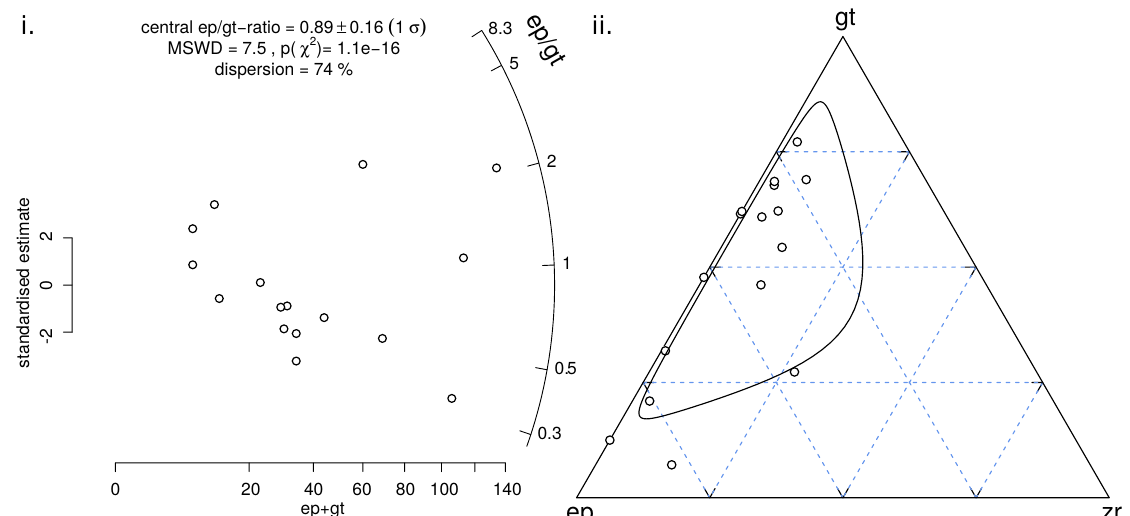
Figure 2. ( i ) Radial plot of the epidote/garnet-ratios of 16 samples of Namibian desert sand. These data are overdispersed with respect to the point-counting uncertainties, indicating 74% of geological scatter in the underlying compositional data. ( ii ) Ternary diagram of garnet, epidote and zircon, with a 95% confidence envelope for the underlying population, using a ternary generalisation of the random effects model. Note that four of the samples contain zero zircon counts. However, this does not pose a problem for the random effects model, unlike the logratio-procedure used for Figure